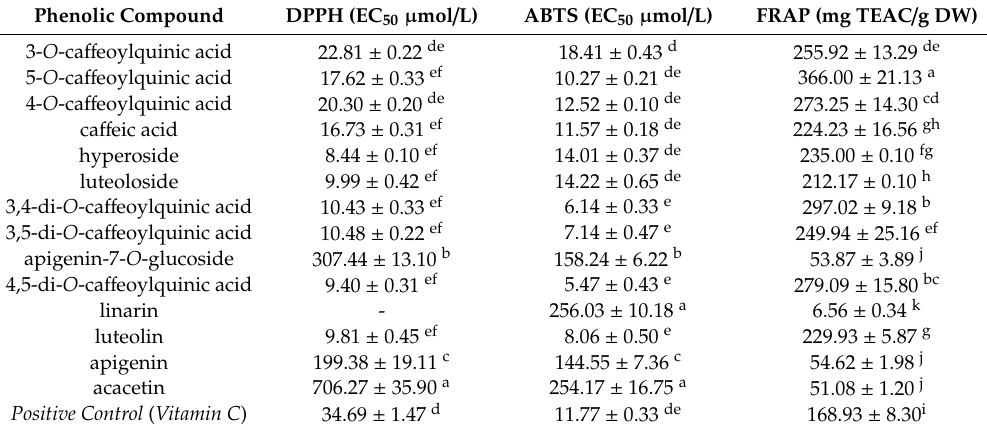
Table 5. Antioxidant activities of individual phenolic compounds.